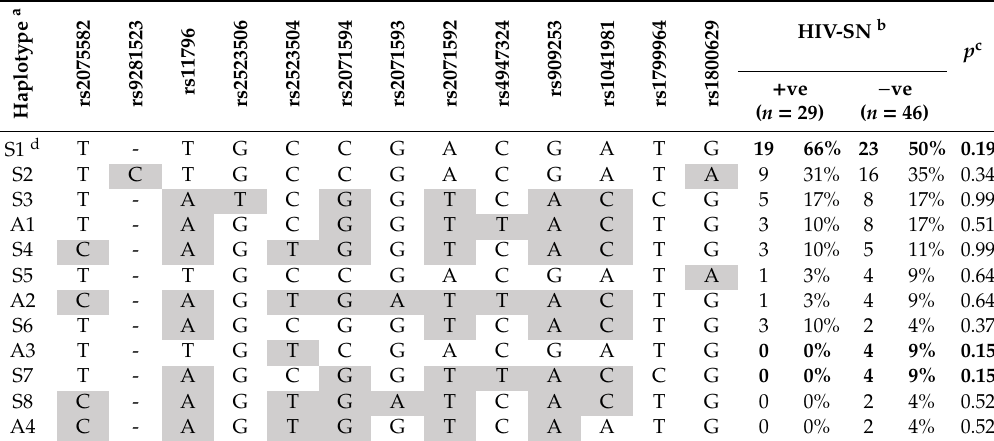
Table 6. Three haplotypes were weakly associated with HIV-SN in